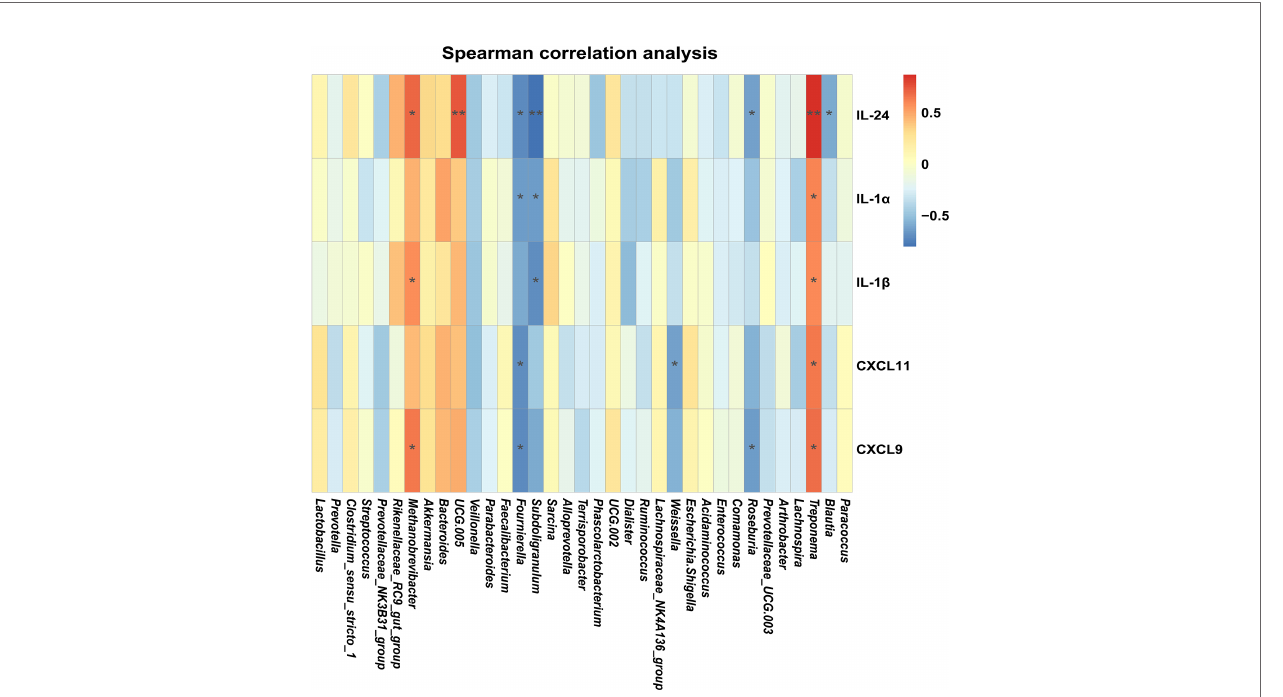
FIGURE 5 | MES-mediated mitigative effects in piglets with DSS-induced colitis are correlated with gut microbiota alteration and colonic in fl ammation: heatmap of the Spearman correlation analysis between the gut microbiota and colonic proin fl ammatory